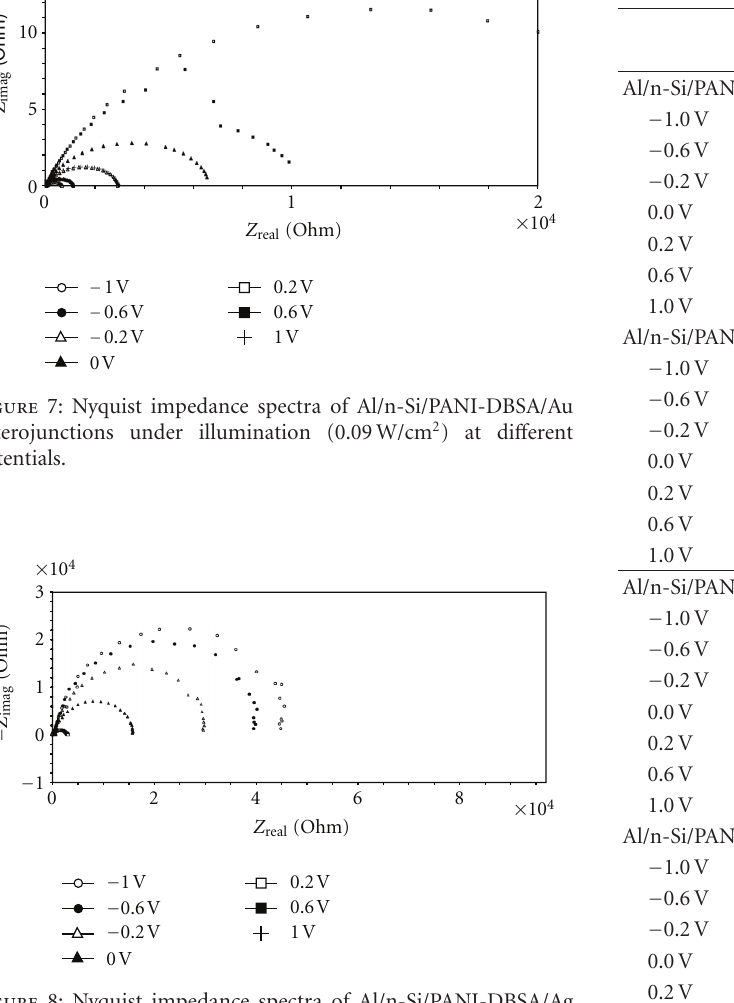
Figure 8: Nyquist impedance spectra of Al/n-Si/PANI-DBSA/Ag heterojunctions under darkness at di ff erent potentials.